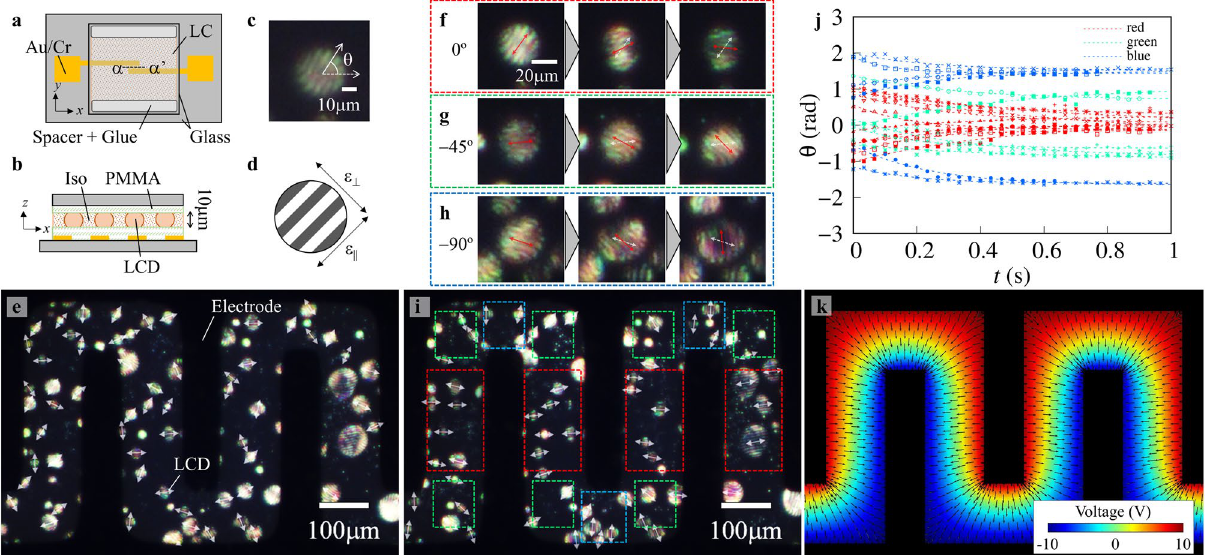
Figure 1. The rotational behavior of LCDs on microcomb electrodes. (a) Top view schematic illustration of the model device. We defined x - and y -axes as shown in this figure. (b) Cross-sectional view (α–α ′ ) of the model device. We patterned comb-Au/Cr electrodes on the lower glass substrate and dispersed LCDs just above the electrodes. The thickness of the cell was 10 µm. (c) POM images of an LCD. We defined the angle between the x -axis and the striped texture as θ. (d) Schematic illustration showing the dielectric anisotropy of LCD. Dielectric constants parallel and perpendicular to the striped texture and denoted as ε || and ε ⟂ , respectively. The LC sample has positive dielectric anisotropy (Δε = ε || − ε ⟂ > 0). (e) POM images of LCD on microcomb electrodes before voltage application, and white arrows indicate the direction of n . POM images of LCDs after voltage application with θ ∞ = (f) 0°, (g) − 45°, and (h) − 90°. Snapshots were taken every 2/3 s. We represent n ( t ) and initial n ( t = 0) as red arrows and white dashed arrows, respectively. (i) POM image of LCDs after voltage (20 V, 10 kHz) application for 5 s, and white arrows indicate n . We divide the observation area into three zones surrounded by red, green, and blue lines depending on the equilibrium direction of LCDs. (j) Time evolution of θ. Red, green, and blue markers indicate the θ( t ) of LCD at the corresponding area of (i) . (k) Voltage distribution on the microcomb electrodes calculated numerically by COMSOL. The color map indicates the electric potential. We showed the direction of electric fields as